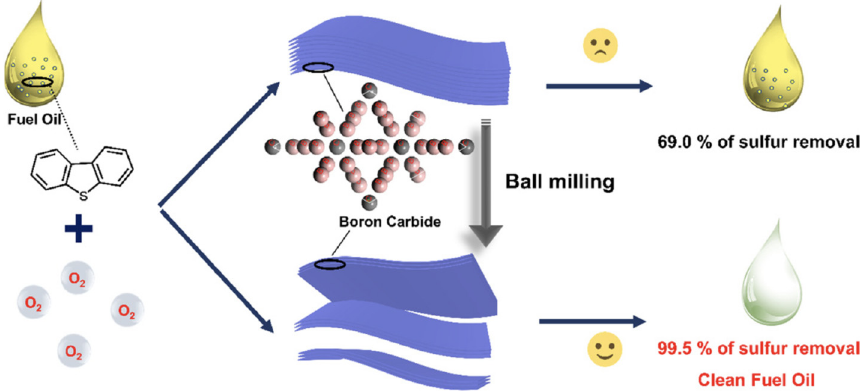
Figure 14. Scheme of exfoliated metal-free boron carbide for aerobic oxidative desulfurization